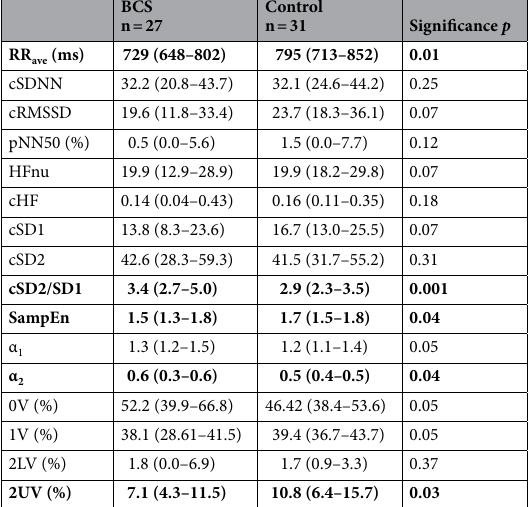
Table 2. Comparison of linear and nonlinear heart rate variability (HRV) indexes between the Breast Cancer Survivors (BCS) and Control groups. Data are presented as median (25th, 75th percentiles). Mann–Whitney’s U tests between BCS and Control groups. Bold values correspond to significant results ( p value < 0.05).